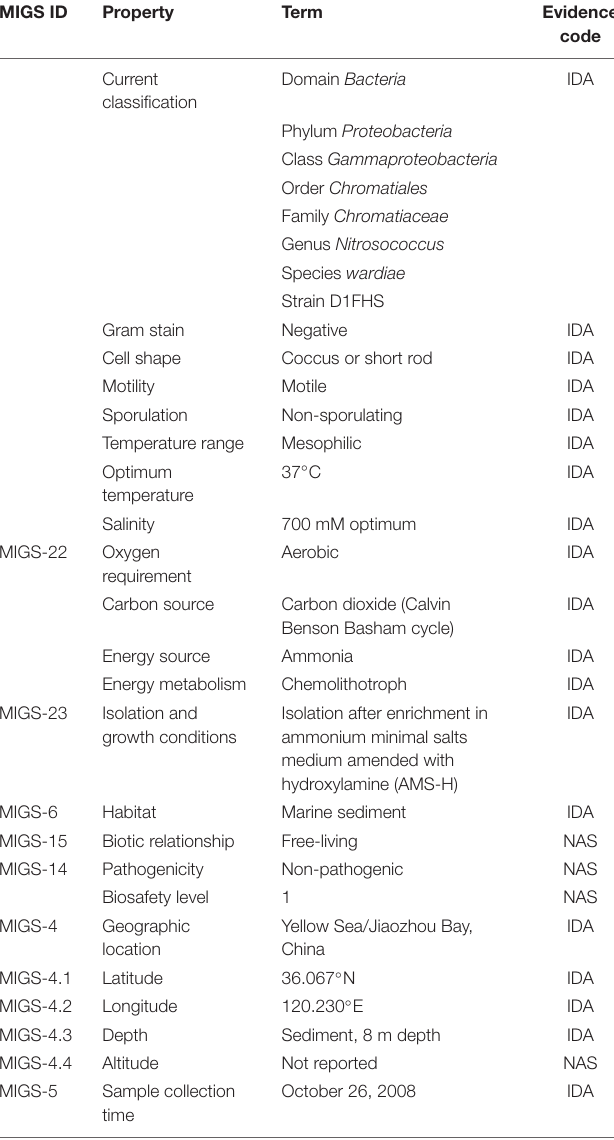
TABLE 4 | Classification and general features of Nitrosococcus wardiae D1FHS according to MIGS Recommendations (Chain et al., 2009). MIGS